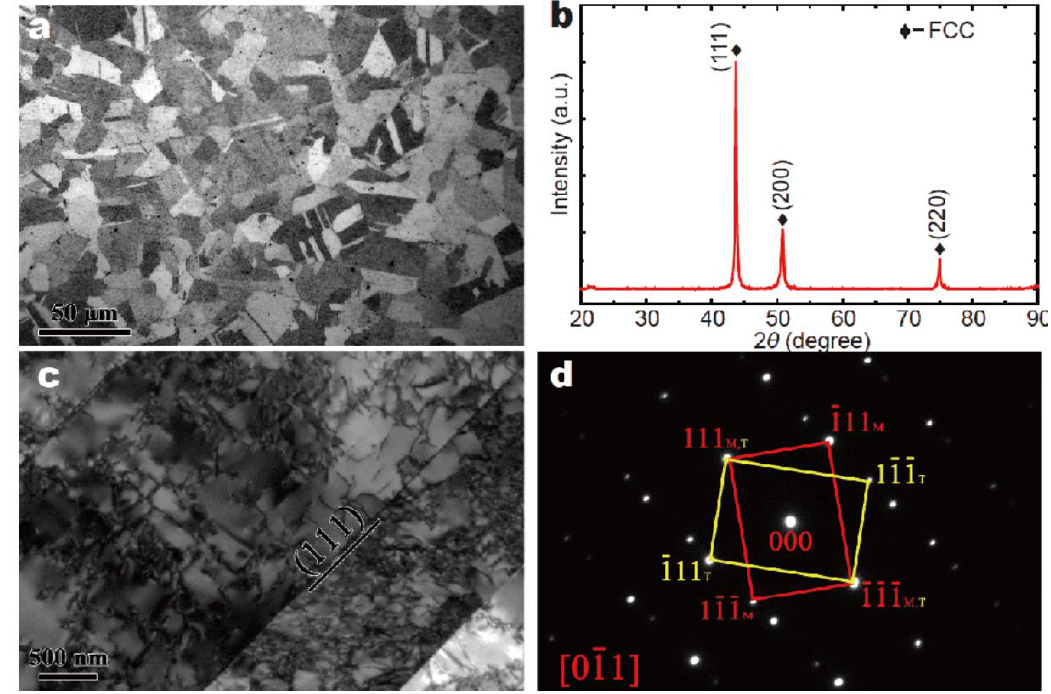
Figure 45. The results of the ( a ) optical microscopy imaging, ( b ) XRD characterization, ( c ) TEM image, and ( d ) selected area electron diffraction results for the CoCrFeNi HEA (reproduced from Reference [159] with permission).